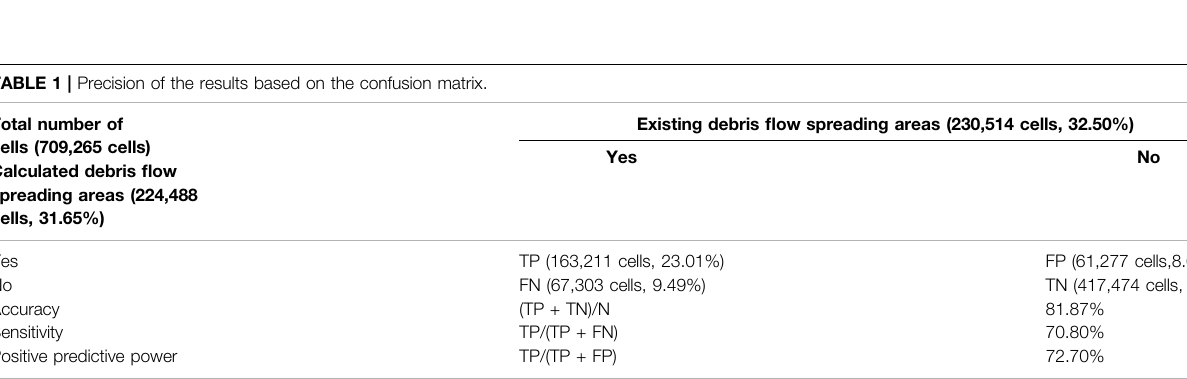
TABLE 1 | Precision of the results based on the confusion